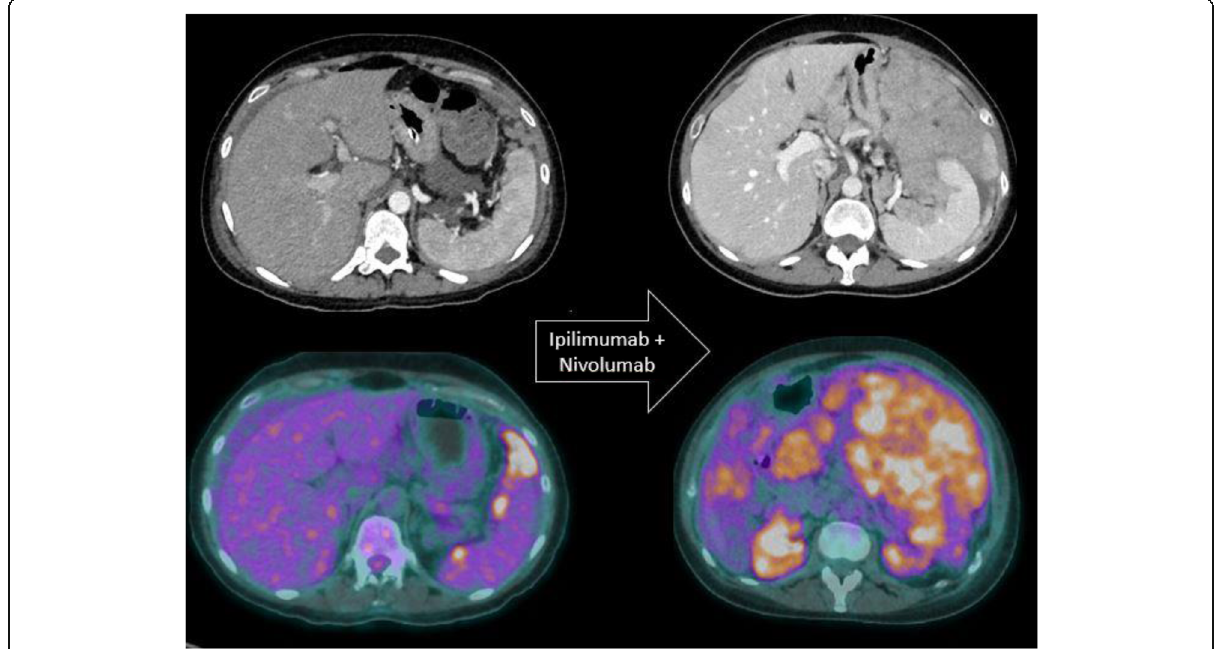
Fig. 4 Paradoxical acceleration of tumour growth kinetics in a patient with metastatic melanoma treated with ipilimumab and nivolumab. Baseline axial CT image and corresponding 18 F-FDG PET/CT image show few perisplenic peritoneal metastatic implants. Two months after the initiation of immunotherapy, both imaging modalities show a dramatic increase in peritoneal